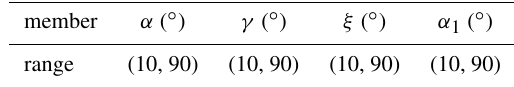
Table 2. Length range of the rod.